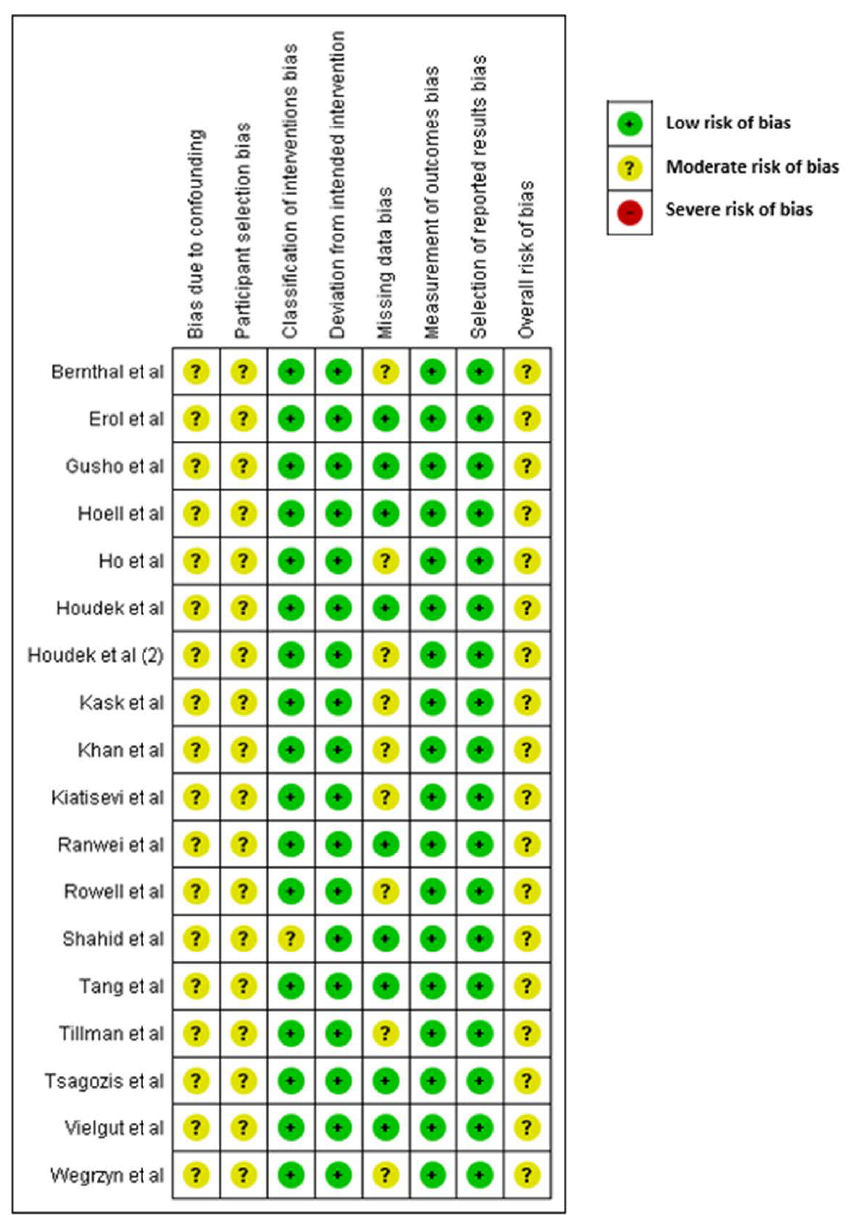
Figure 2. Results of quality assessment using ROBINS-I tool .